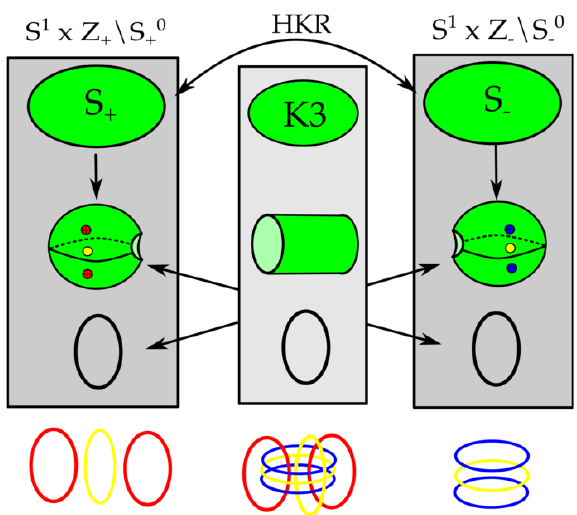
Figure 11 . TCS construction of G 2 -manifolds. Top: building blocks that are aCyl Calabi-Yau and hyper-K(cid:127)ahler rotation (HKR) in asymptotic cyclindrical region. Bottom: Higgs bundle data. The critical loci of the Morse-Bott function f (in yellow) and the charge con(cid:12)guration (cid:26) (in red and blue) corresponding to the local limit of a TCS G 2 -manifold. The (cid:12)gure on the top shows the decomposition of S 3 into C (cid:6) (cid:2) S 1 and the (cid:12)gure on the bottom shows the location of the same (cid:6) critical loci and charges in a patch R 3 of S 3 . Every every circle in X + (cid:2) S 1 has linking number one + with any of the circles in X + (cid:2) S 1 . Note that charge conservation requires that not all loops carry + identical charges in this